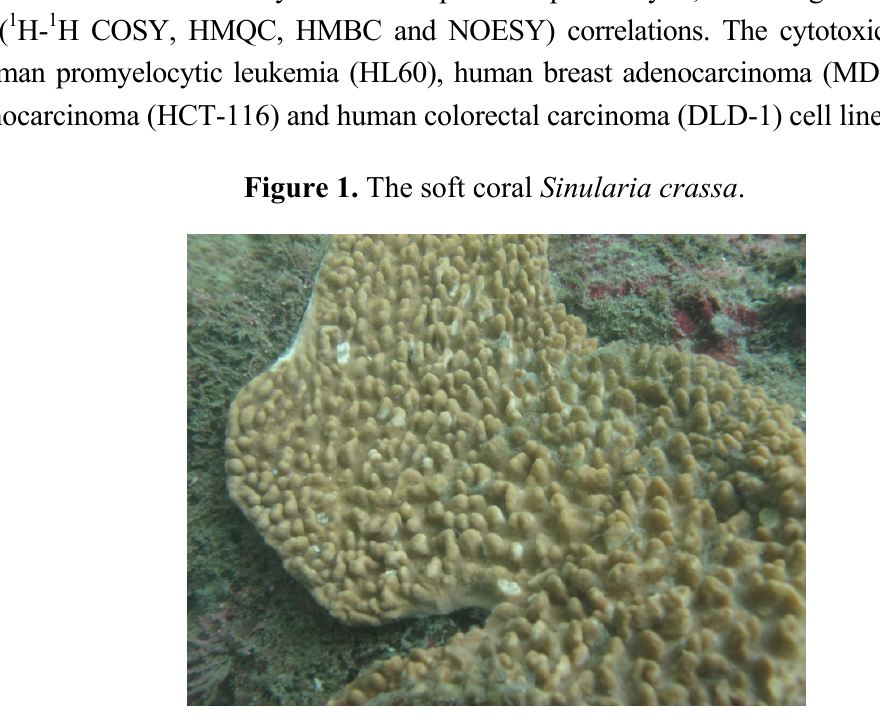
Figure 2. The structure of metabolite 1 and selected 1 H- 1 H COSY ( ▬ ) and HMBC ( → )